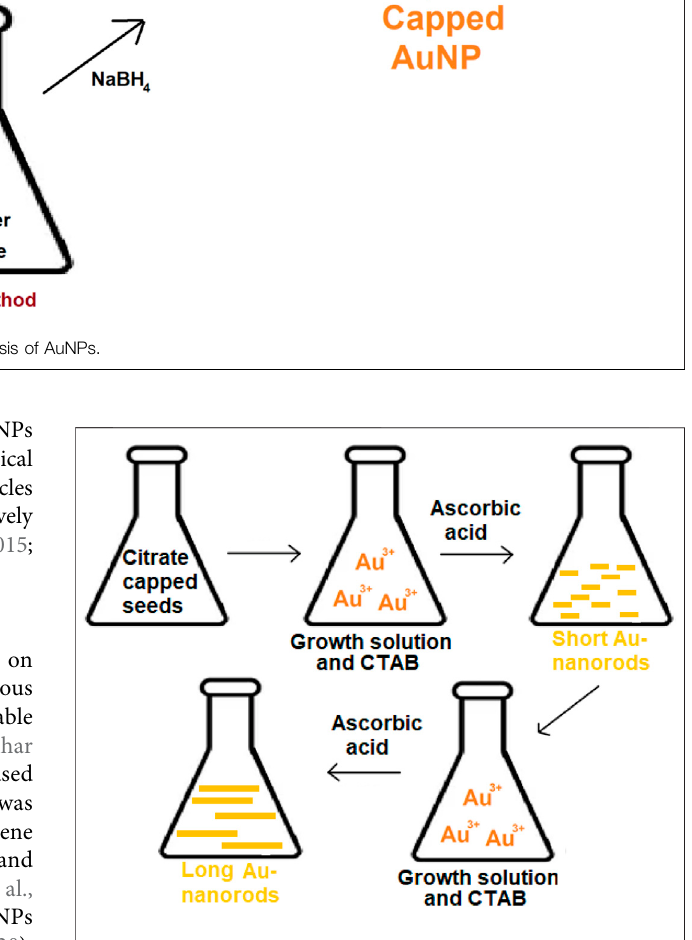
Frontiers in Bioengineering and Biotechnology |